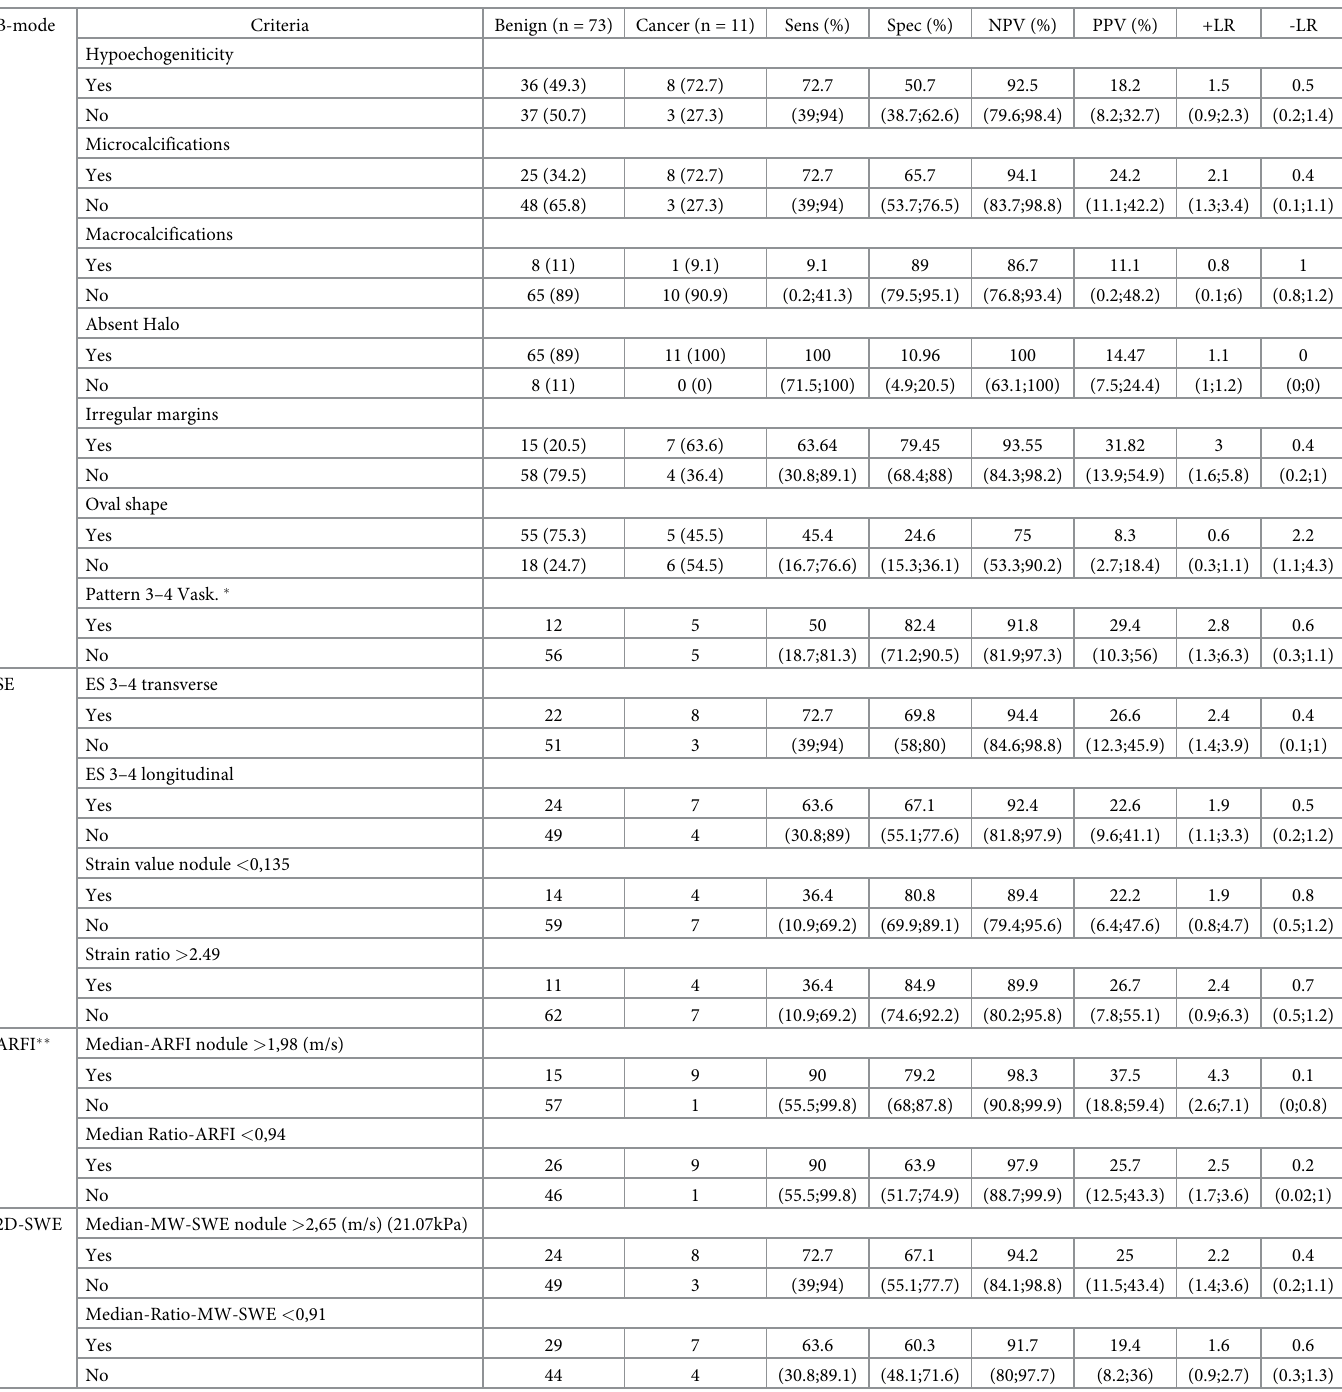
Table 2. Sensitivity, specificity, PPV and NPV for malignant thyroid nodules for different ultrasound patterns (including SE, ARFI and 2D-SWE).